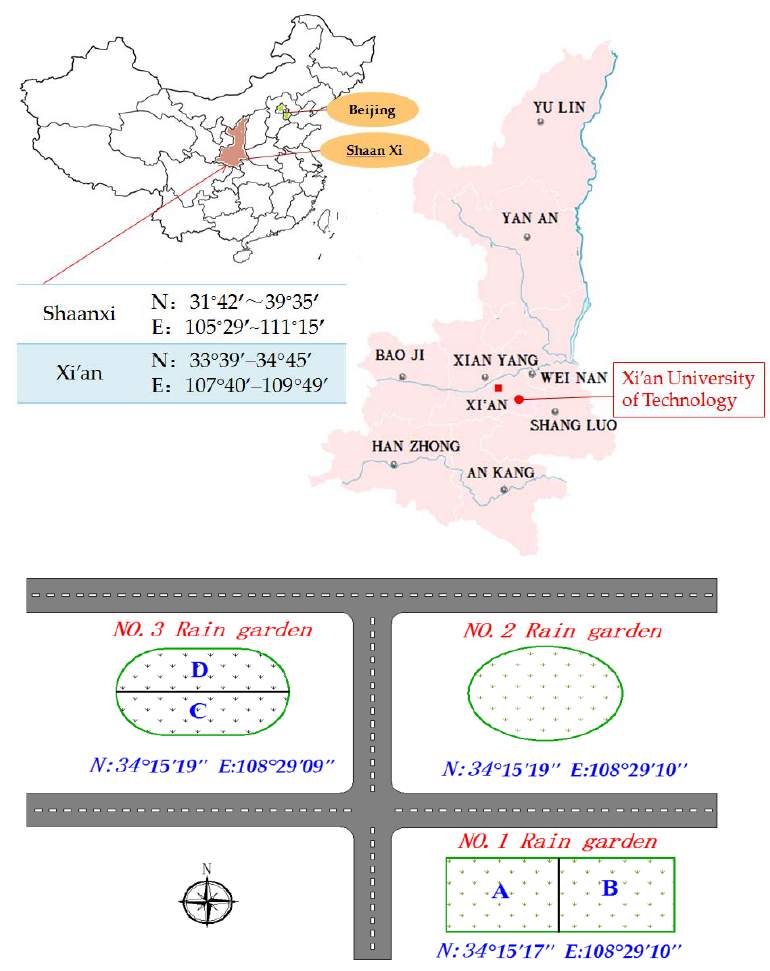
Figure 1. Location of the experimental rain gardens.